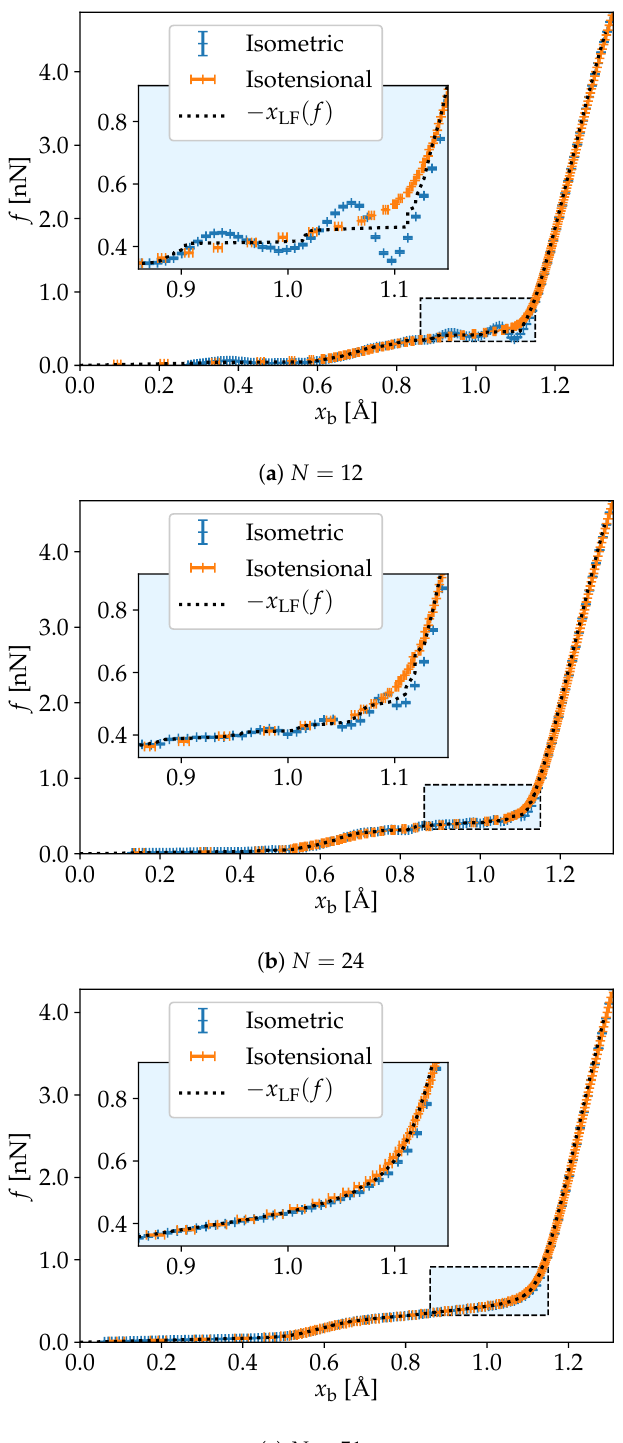
Figure 4. The force-elongation curve x LF computed from the Legendre–Fenchel transform cf. Equation (17) is compared to the force-elongation curves from Figure 1. We recognize the singular points in G LF as jumps in x LF ( f ) , particularly visible in the smallest system with N =